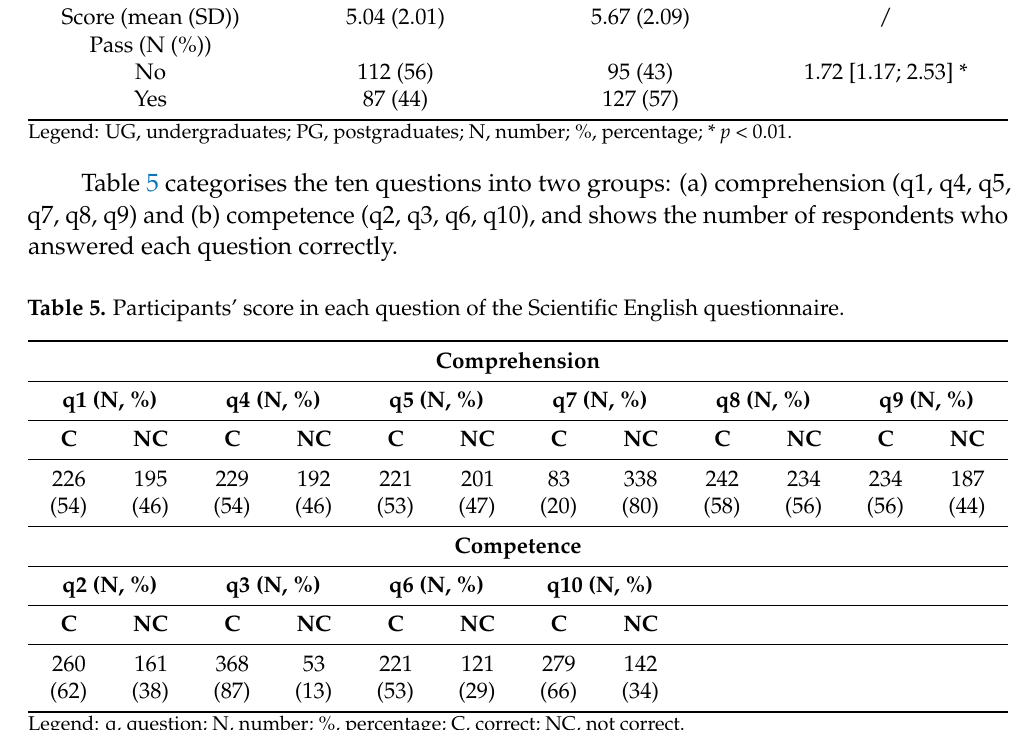
Table 4. Participants’ total score in the Scientific English questionnaire. Questionnaire Score